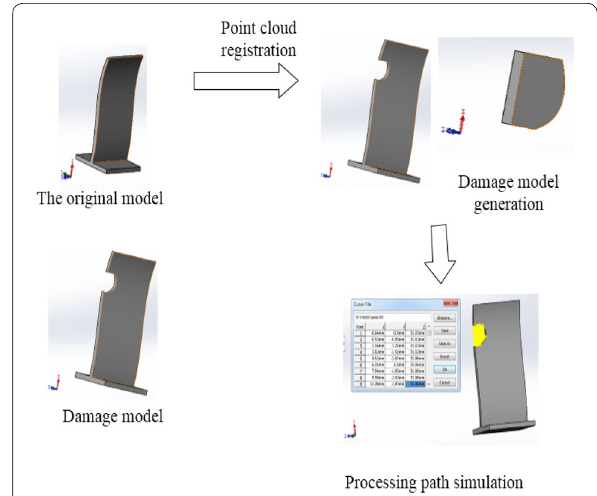
Figure 13 Schematic diagram of damage model